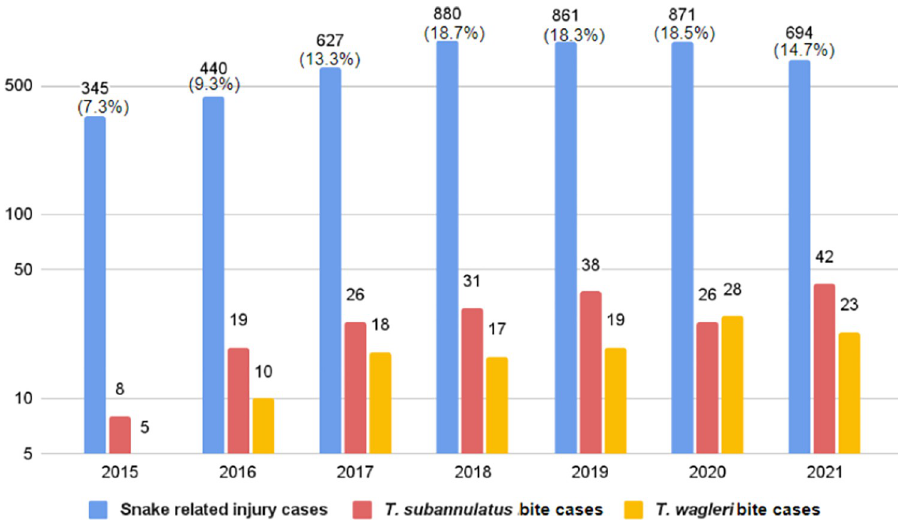
Fig 2. Annual number of snake related injury consulted to RECS and the number of Tropidolaemus subannulatus and Tropidolaemus wagleri bite cases from 2015 to 2021.